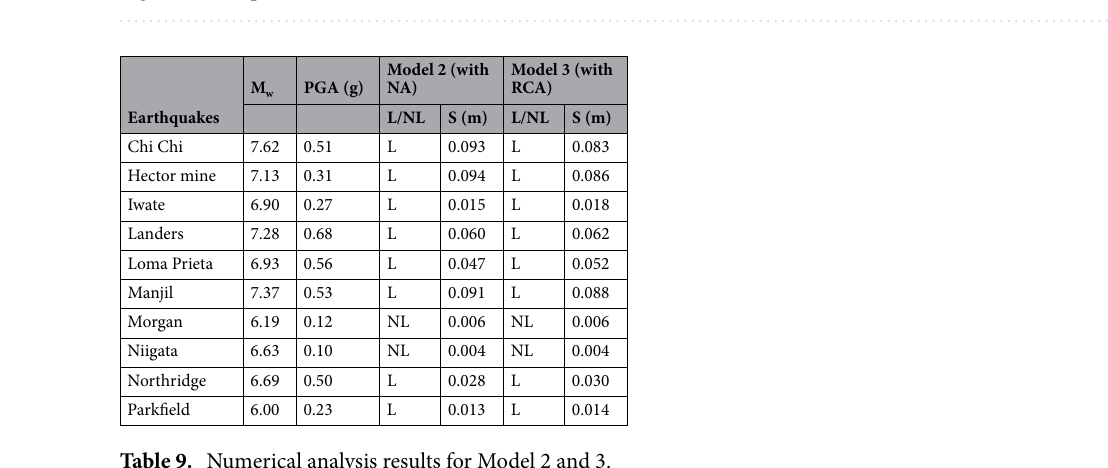
Figure 14. Liquefaction-induced settlement results for Model 1.